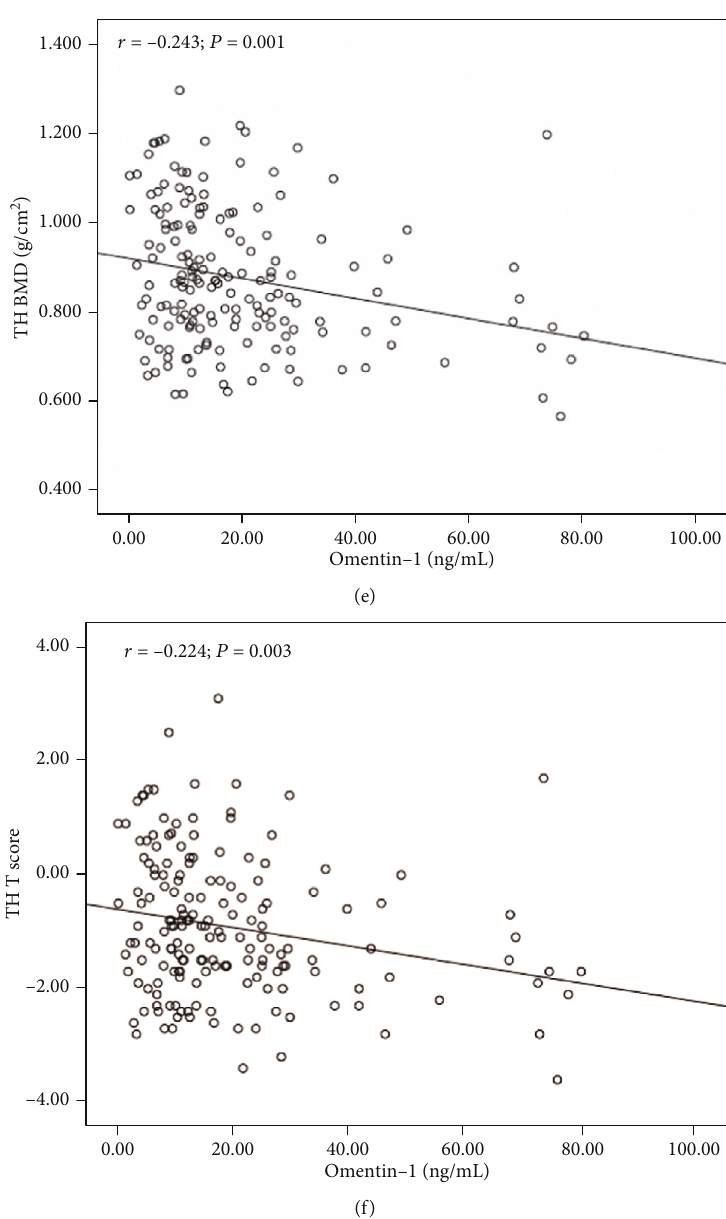
Figure 2: Correlations between circulating omentin-1 and BMD at di ff erent skeletal sites and corresponding T scores. (a) LS BMD, (b) LS T score, (c) FN BMD, (d) FN T score, (e) TH BMD, and (f) TH T score in patients with all study